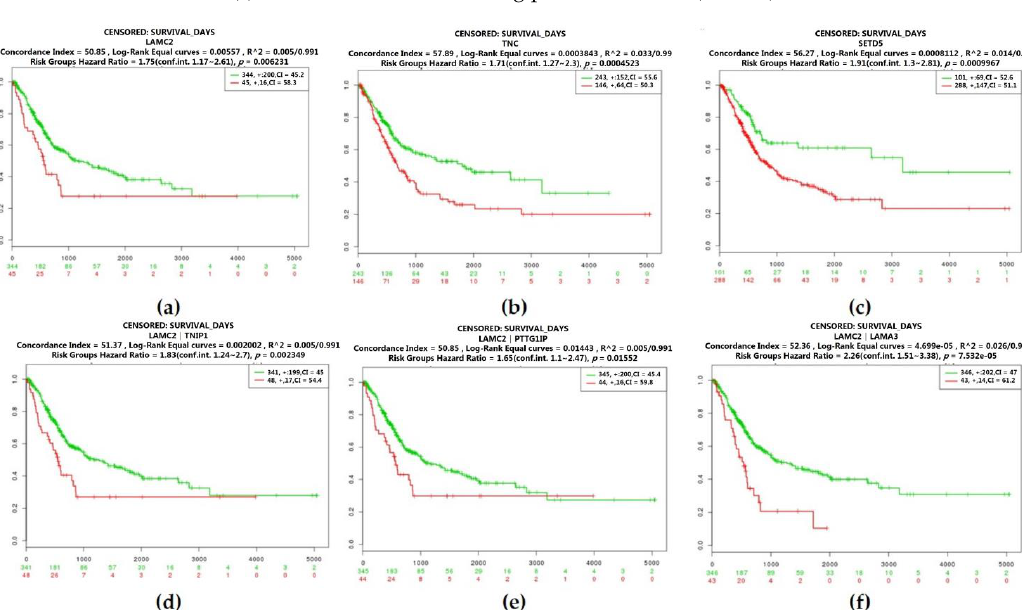
Figure 7. Overall survival of the co-expression of hub genes of bladder cancer with grade 2 carcinoma based on Kaplan–Meier plotter. The horizontal axis represents the time to event. The patients were stratified into the high-level group and low-level group and labeled with color. The red line indicates the samples with high risk, and the green line shows the samples with low risk. p < 0.05 is considered a statistically significant difference in mortality between the high-level group and low-level group. ( a ) Laminin subunit gamma 2 (LAMC2); ( b ) Tenascin C (TNC); (c) SET domain containing 5 (SETD5); ( d ) Co-expression of LAMC2 and TNIP1; ( e ) Co-expression of LAMC2 and PTTG1IP; ( f ) Co-expression of LAMC2 and LAMA3; ( g ) Co-expression of LAMC2 and SEC3; ( h ) Co-expression of LAMC2 and TMEM132A; ( i ) Co-expression of LAMC2 and THBD. Abbreviation: TNIP1 TNFAIP3 Interacting Protein 1 , PTTG1IP Prostaglandin-endoperoxide synthase 1 , LAMA3 Laminin subunit alpha-3 , SEC3 Exocyst complex component 1 , TMEM132A Transmembrane protein 132A , THBD Thrombomodulin .